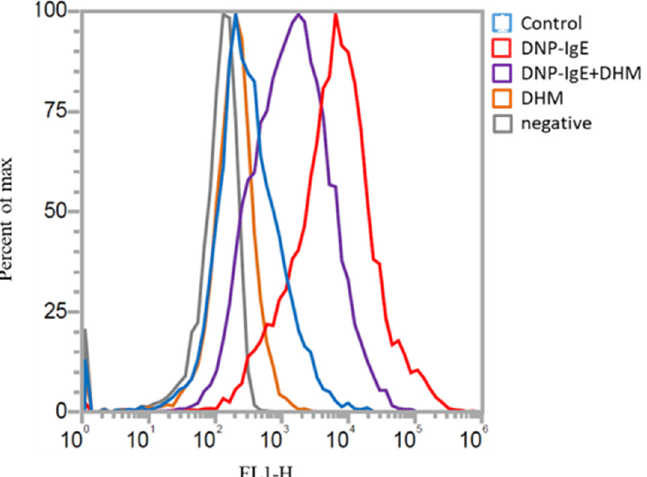
Figure 2. DHM (100 µ M) alleviates the oxidative levels in IgE-activated KU812 cells. Representative flow cytometry profiles show changes in the levels of ROS in IgE-challenged KU812 cells after treatment with DHM. A histogram of fluorescence channel (FL1-H) versus cell count (y-axis) was generated to show cells stained with DCFH-DA in comparison to the non-sensitized control cells. Three independent, representative experiments are